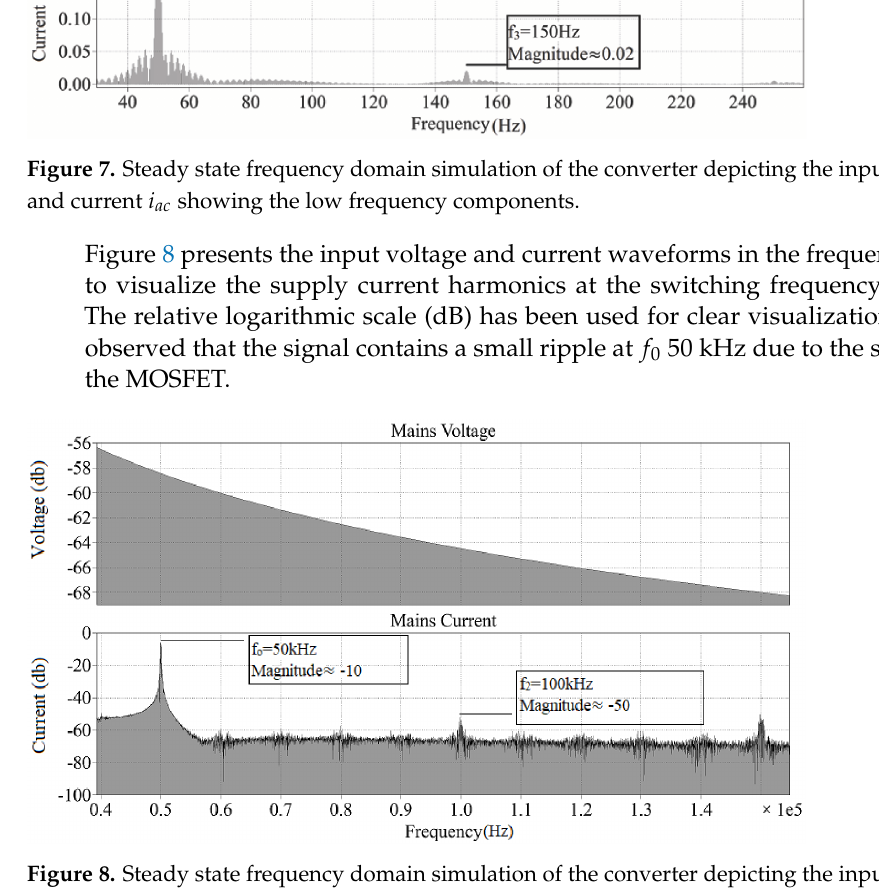
Figure 8. Steady state frequency domain simulation of the converter depicting the input voltage V ac and current i ac showing the high frequency